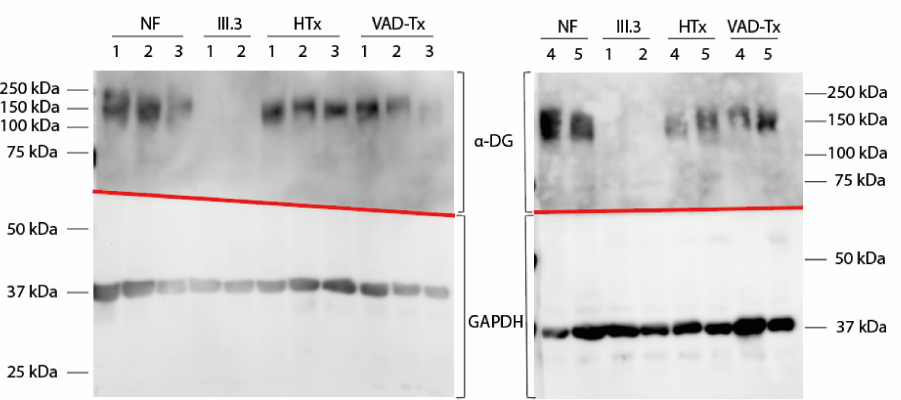
Figure 3. Western blot detection of α -dystroglycan ( α -DG) and glyceraldehyde-3-phosphate dehy- drogenase (GAPDH) in left ventricular tissue. Tissue samples from the index patient at the time of VAD implantation (III.3, 1) or at the time of VAD explantation (III.3, 2) were used. Five donor hearts (NF), five samples obtained from cardiomyopathy patients at heart transplantation (HTx), and five samples received after VAD explantation from cardiomyopathy patients (VAD-Tx) were used as controls. According to the literature, α -DG was expected to be 140 kDa and GAPDH was expected to be 37 kDa. GAPDH was observed as expected in all samples. An appropriate signal for α -DG was observed in all controls (NF, HTx, and VAD-Tx) but not in the myocardial tissue of the index patient (III.3). Fuzzy bands in the α -DG part of the Western blot were caused by differential glycosylation of α -dystroglycan.